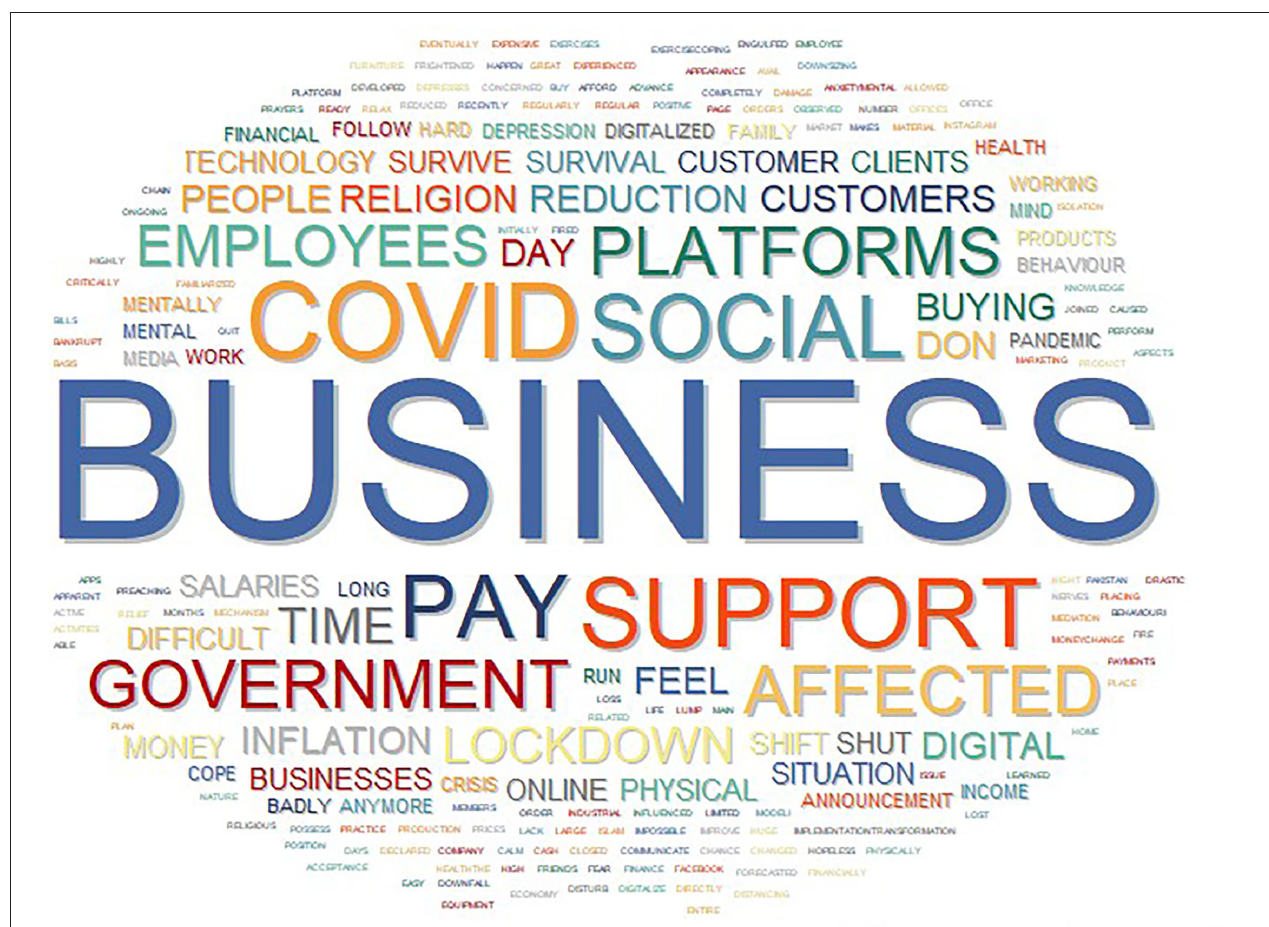
FIGURE 1 | Visual words